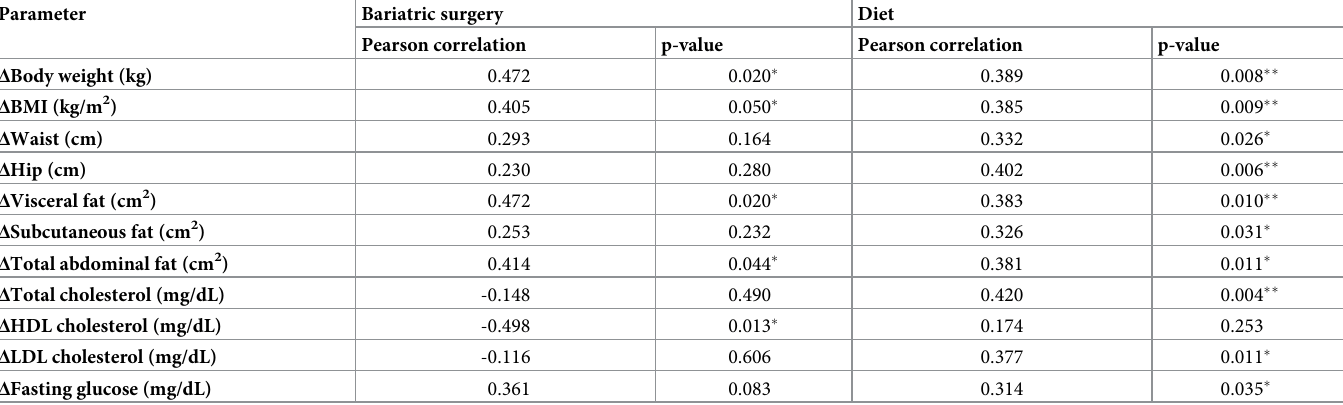
Table 4. Correlations between the decrease in PRCP activity and changes in several metabolic and biochemical parameters after diet or bariatric surgery ( (cid:3) p (cid:20) 0.05, (cid:3)(cid:3) p (cid:20) 0.01). Parameter